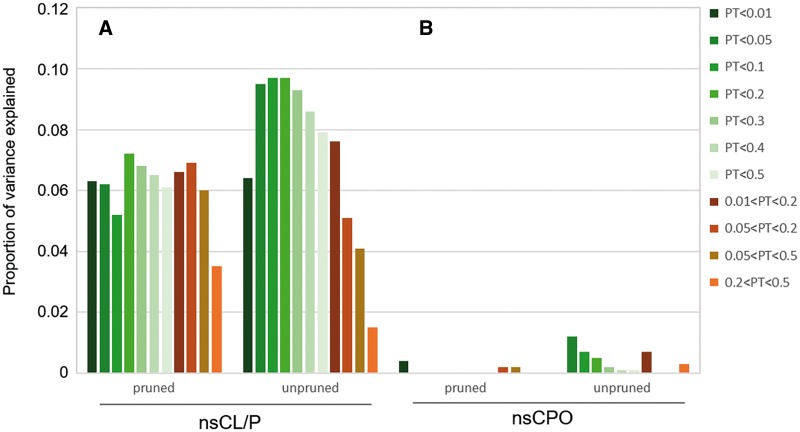
Polygenic risk score analysis in nsCL/P and nsCPO. The amount of variance explained in the target samples based on the polygenic score derived from the Bonn case-control GWAS nsCL/P discovery sample: (A) for the nsCL/P European trio sample; (B) for the nsCPO European trio sample. The amount of variance explained, denoted as Nagelkerke’s pseudo R2, is shown on the y-axis. Different association test P-value thresholds (PT) in the discovery dataset are represented by different colours. Results are shown for both pruned and unpruned analyses, respectively.